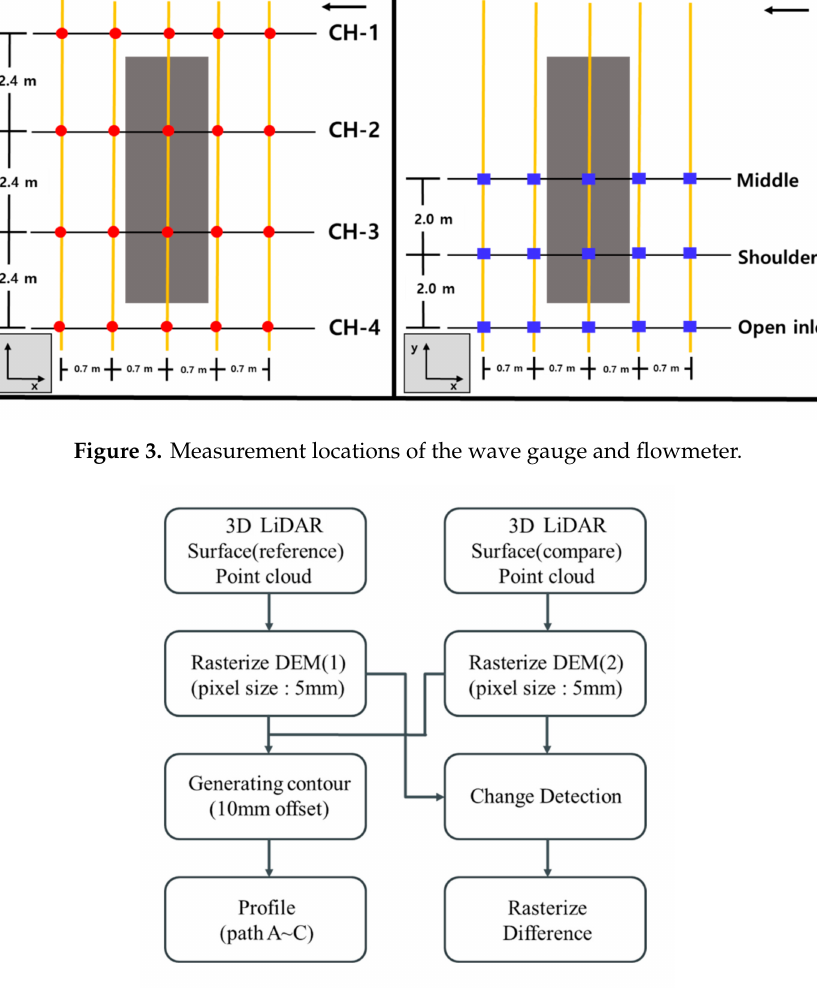
Figure 4. Data calibration and